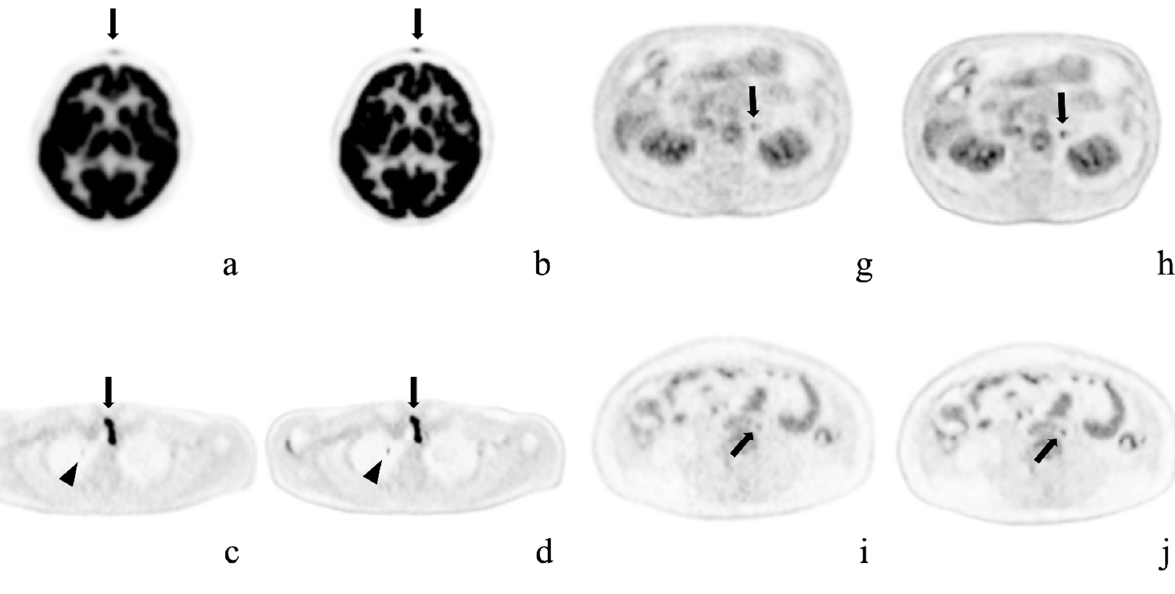
Figure 3. Representative cases. Axial positron emission tomography images with conventional Gaussian filtering ( a , c , e , g , i , k ) and those obtained with deep learning reconstruction ( b , d , f , h , j , l ). These pathological lesions were missed or were considered physiological uptake by OSEM imaging alone, but were detected on AiCE (DLR) imaging. ( a , b ) Forehead cutaneous nodule (arrows) in a 64-year-old woman; ( c , d ) Right superior pulmonary lobe (arrowheads) and superior mediastinal lymph node (arrows) in a 58-year-old man after surgery for thyroid cancer; ( e , f ) Anterior mediasti- nal (arrows) and right hilar (arrowheads) lymph node metastases in a 73-year-old woman with right inferior lung cancer; ( g , h ) Left adrenal adenoma in an 80-year-old man; ( i , j ) Enlarged para-aortic lymph node in a 41-year-old woman; k, l) Sacral metastasis (arrows) in the same patient. 4. Discussion In this study, we investigated improvements in image quality using AiCE (DLR method) for semiconductor FDG-PET/CT imaging. In the qualitative assessment, the images obtained using the AiCE had a significantly higher quality than the OSEM images. Van Sluis et al. found that semiconductor PET im- ages were superior to conventional PET images in terms of lesion demarcation, visually assessed signal-to-noise ratio, and overall image quality [19]. Here, we demonstrate that AiCE can further improve the quality of semiconductor PET images. In healthy organs, 11 of 21 SUV parameters (52.4%) showed significant differences between AiCE and OSEM images. These differences were mainly due to the higher SU- Vmax and SUVpeak of OSEM images in larger organs, such as the liver, spleen, and quad- riceps muscles. This result is probably due to edges being denoised, as observed in our previous study [25]. In large organs, both AiCE and OSEM methods remove the noise without smoothing out the structure. Since AiCE can denoise slightly more than OSEM,